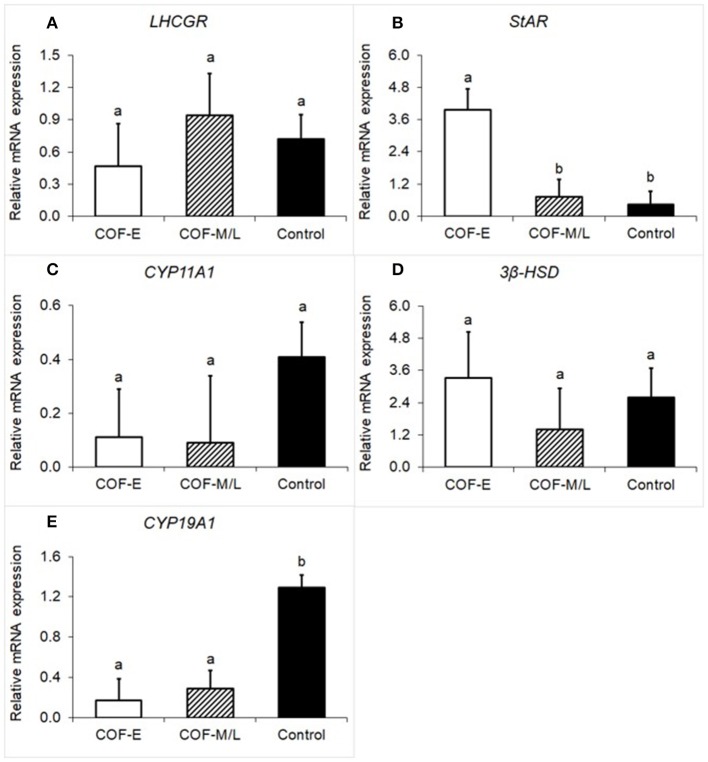
Fold-change in mRNA expression for five steroidogenic enzyme genes (A)
LHCGR, (B)
StAR, (C), CYP11A1, (D)
3β-HSD, and (E)
CYP19A1 detected in follicular fluid in cows diagnosed with COF at early (COF-E) and mid-late (COF-M/L) lactation and the control cows. Different letters (a,b) represent different (0.05 < P ≤ 0.10) least-square means. Error bars represent the mean standard error.